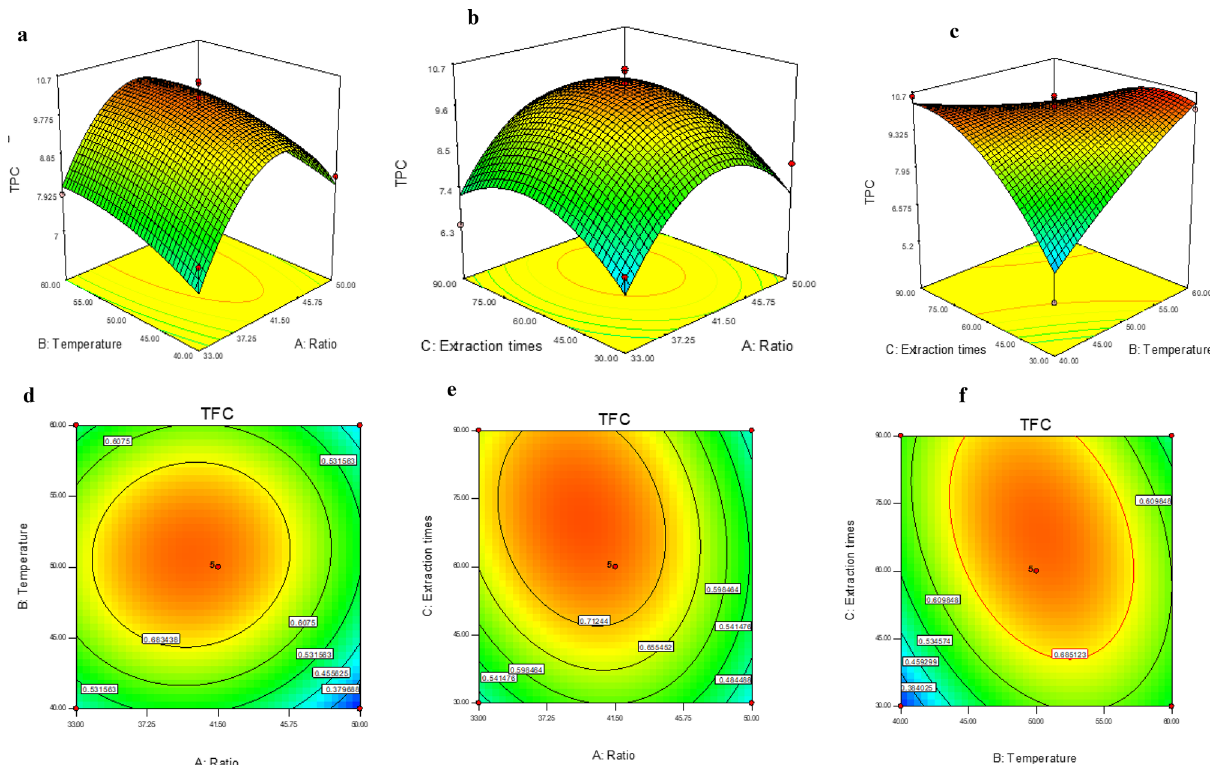
Figure 1. Response and contour plots showing the effect of ratio ( A ), extraction temperature ( B ), extraction time ( C ) on total polyphenols and flavonoids content.